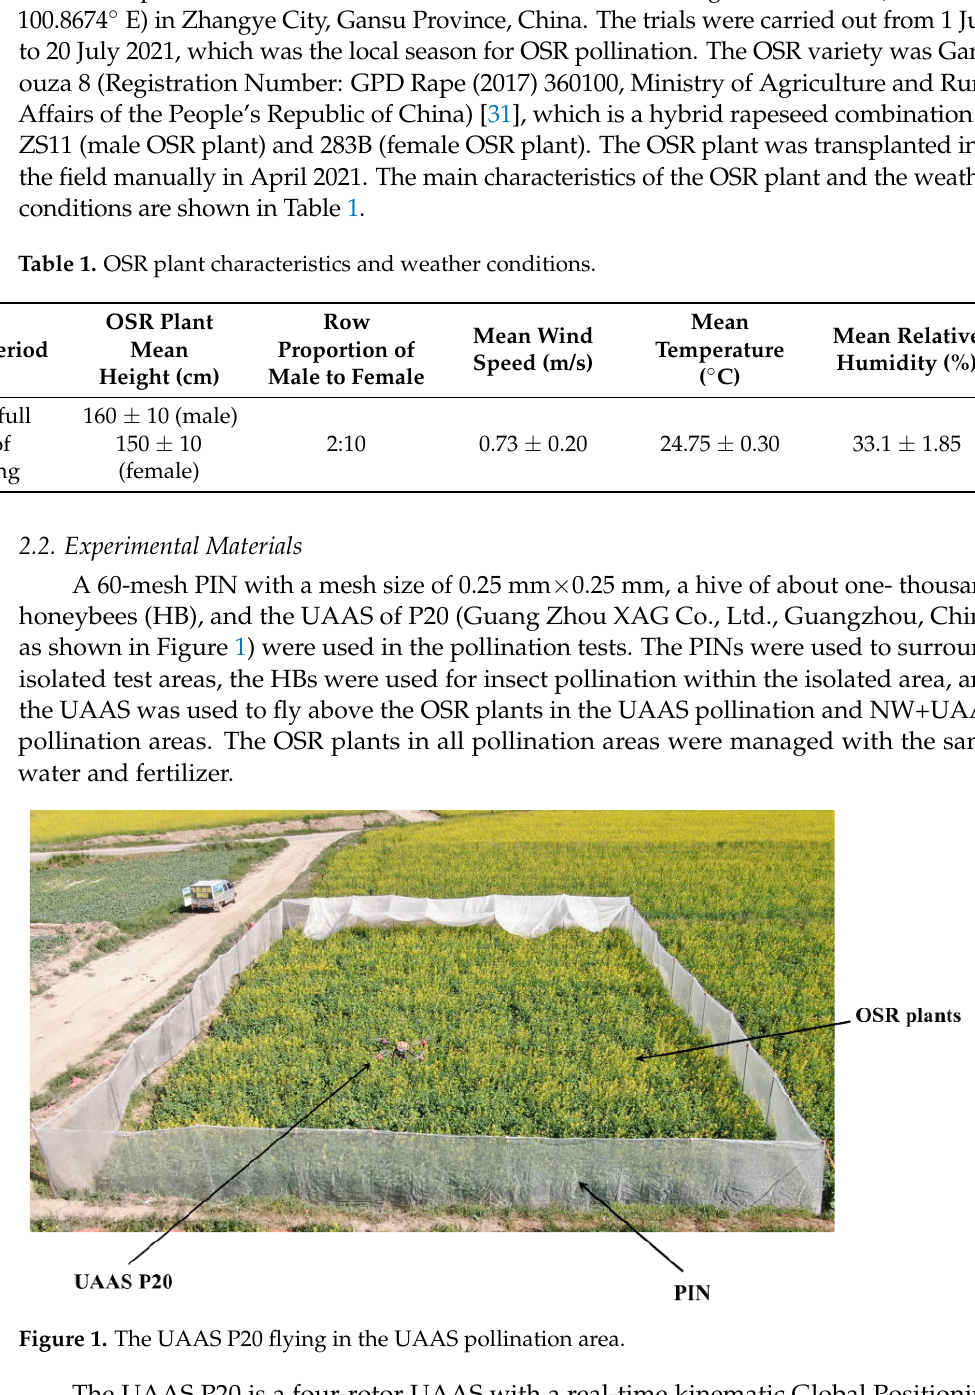
Table 1. OSR plant characteristics and weather conditions.